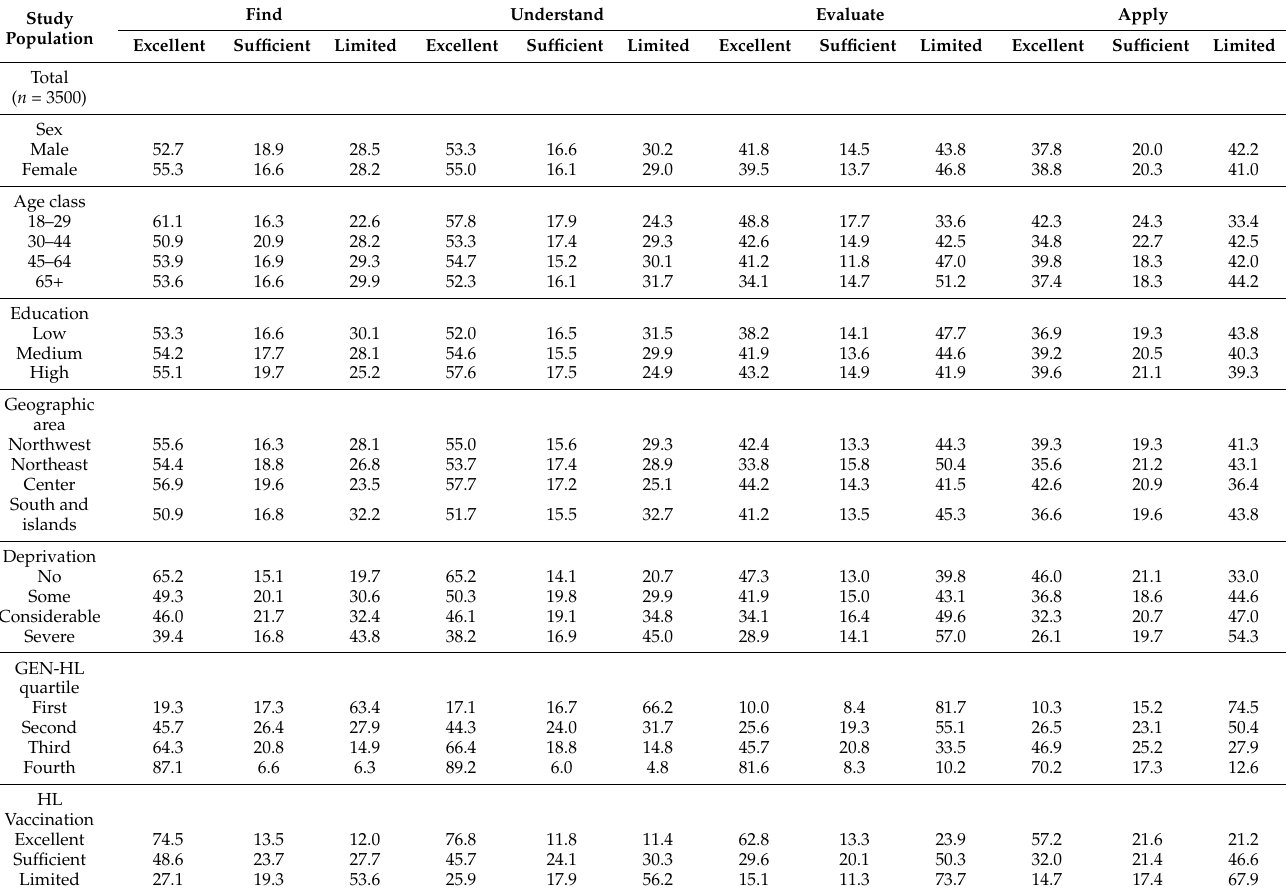
Table 5. HL-COVID levels of process subdimensions by participant